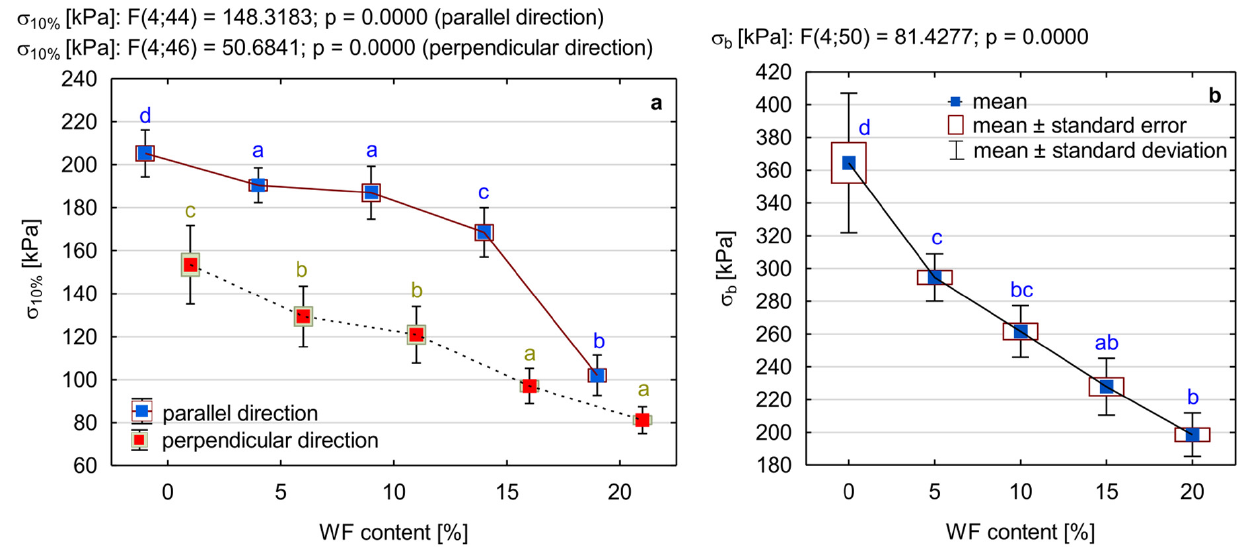
Figure 8. Selected mechanical properties of PUR foam with the addition of different amounts of wood filler: ( a ) compressive strength ( σ 10% ), ( b ) flexural strength ( σ b ). Different letters in colour indicate homogeneous groups of mean values determined by one ‐ factor ANOVA with Tukey’s test.